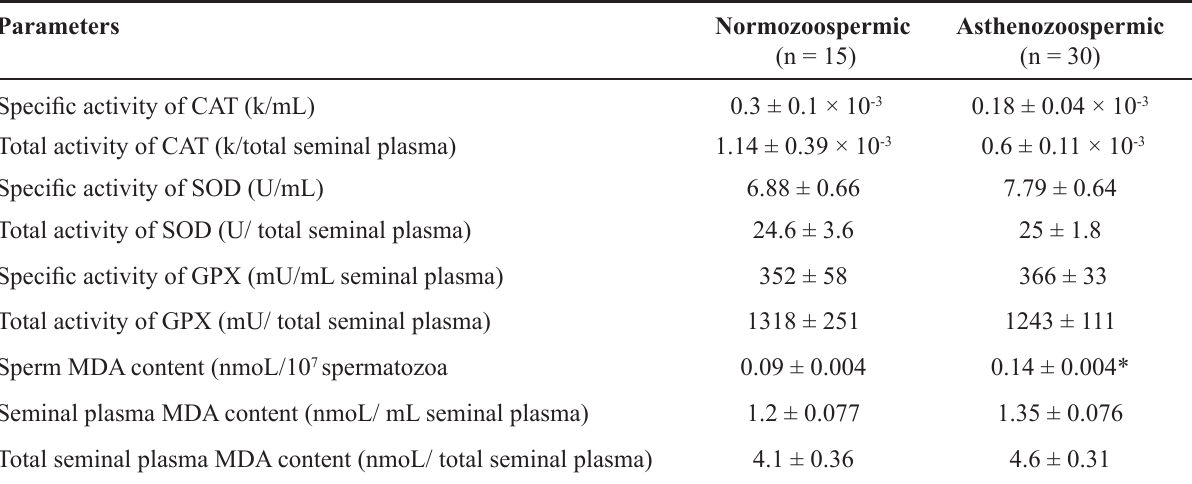
Table 2 – Specific and total activity of catalase (CAT), glutathione peroxidase (GPX), superoxide dismutase (SOD) of seminal plasma and malondialdehyde (MDA) content of spermatozoa and seminal plasma from normozoospermic and asthenozoospermic